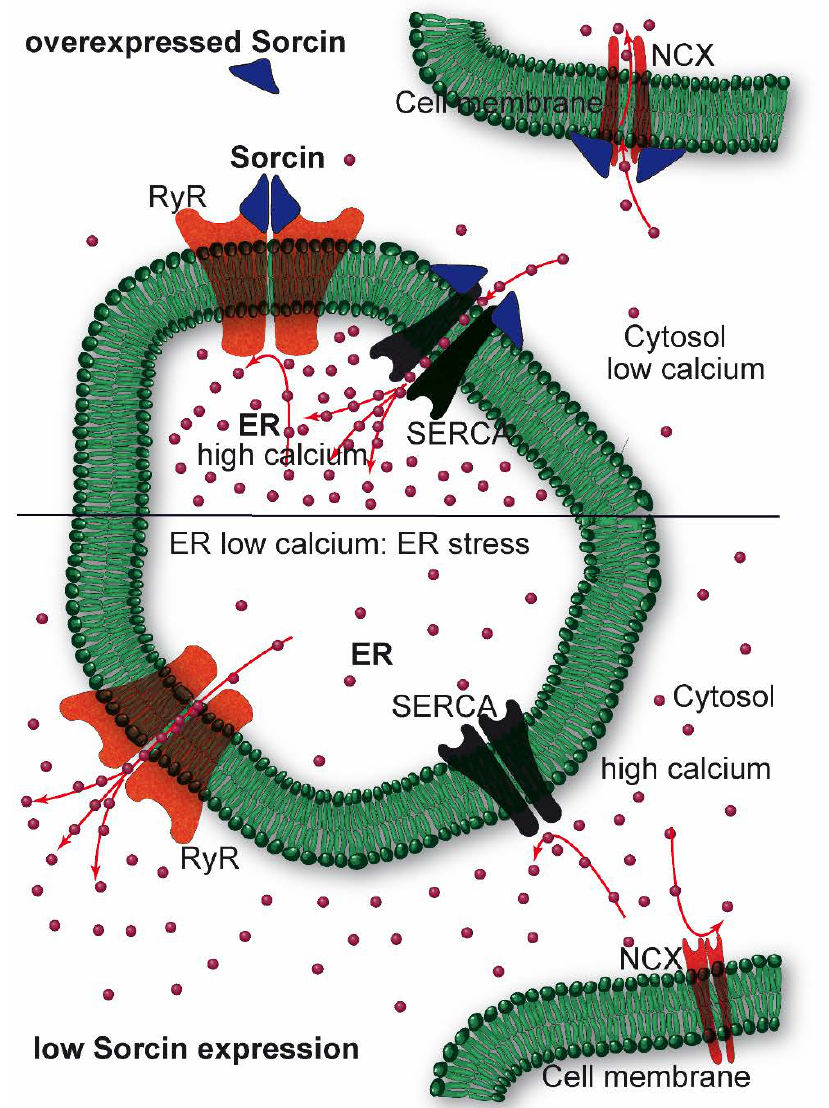
Figure 4. Sorcin inhibits Ryanodine Receptors (RyRs) and activates sarco / endoplasmic reticulum Ca 2 + − ATPase (SERCA) and Na + / Ca 2 + exchanger (NCX), thereby increasing Ca 2 + load of the endoplasmic reticulum (ER) and decreasing ER stress ( top ). When sorcin expression is low, ER Ca 2 + load is decreased, thereby increasing ER stress (bottom).